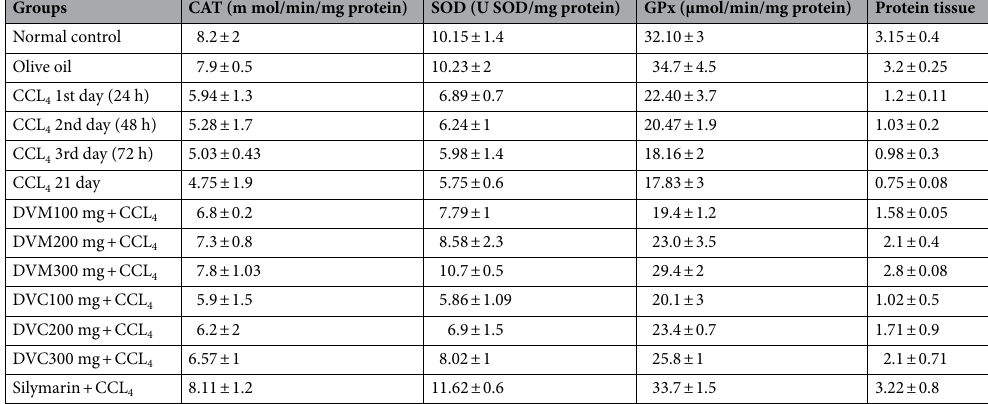
Table 5. Effects of Dodonaea Viscosa flowers on Antioxidant enzymes and total proteins. All the results were obtained in triplicate with mean and standard deviation.